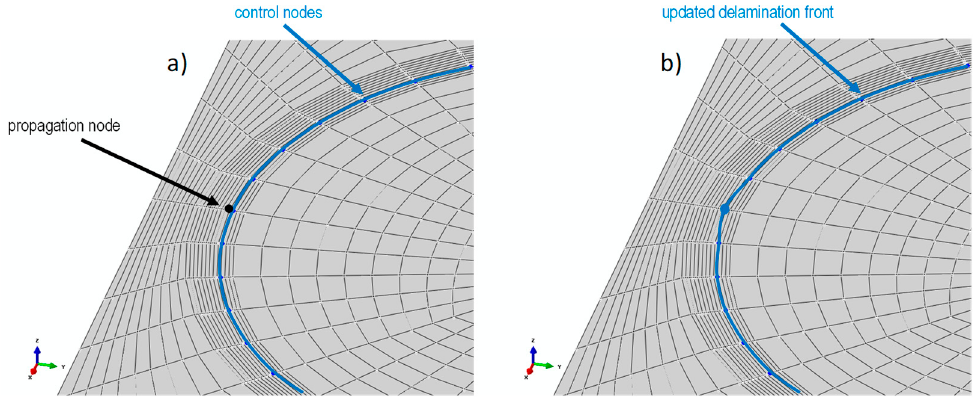
Figure 8. Delamination front propagation node: ( a ) identification and ( b ) release.